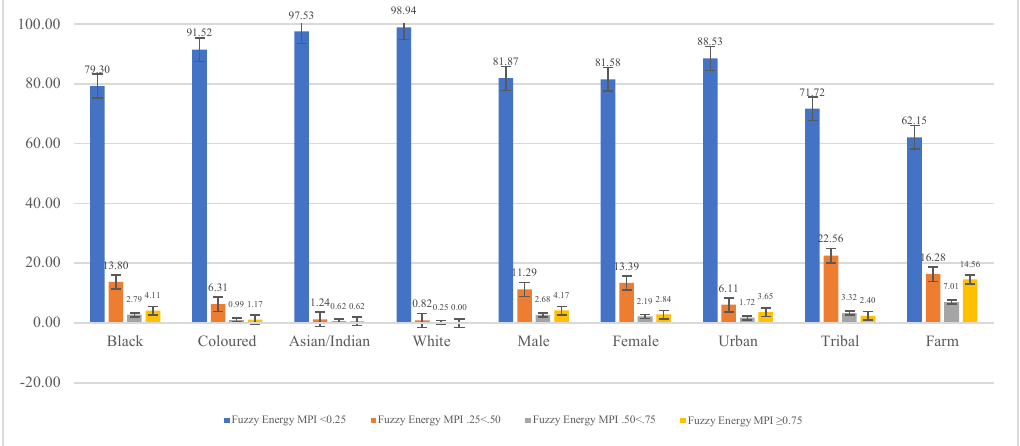
Figure 4. Distribution of fuzzy MEPI across races, genders, and economic sectors in South Africa (2019–2022). Source: GHS datasets (2019–2021).